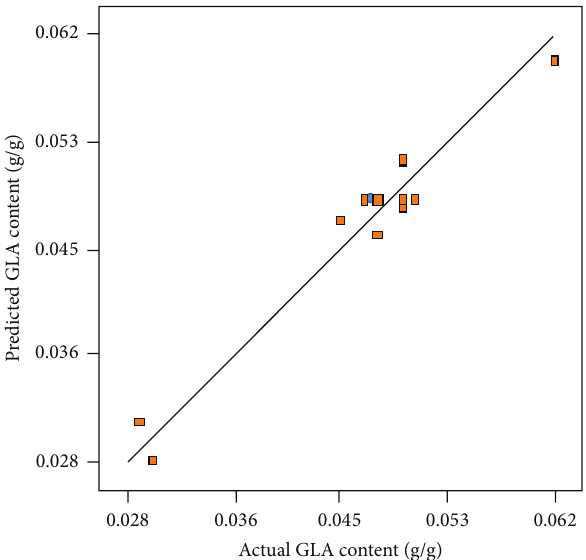
Figure 9: Experimental GLAcontent produced versusthepredicted GLA content by the statistical model under operating conditions.